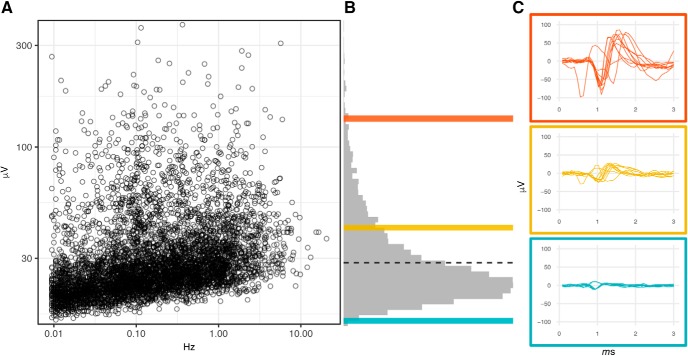
Comparison of firing frequency and wave form amplitude. A, Firing frequency (Hz) and wave form amplitude (μV) for 5506 spike clusters within untreated cortical cultures. Wave form amplitude determined by cluster centroid. B, Distribution of spike cluster wave form amplitudes, dash line indicating 30-μV threshold used for selecting clusters for assessing changes in wave form amplitude in response to treatment. C, Examples of low amplitude (teal), mid amplitude (gold), and high amplitude (persimmon) amplitude waveforms.